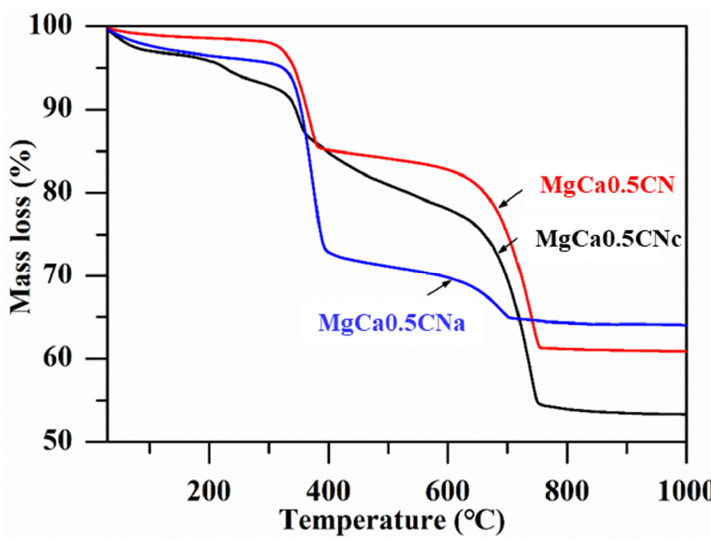
Figure 1. TG curves of the uncalcined catalysts.